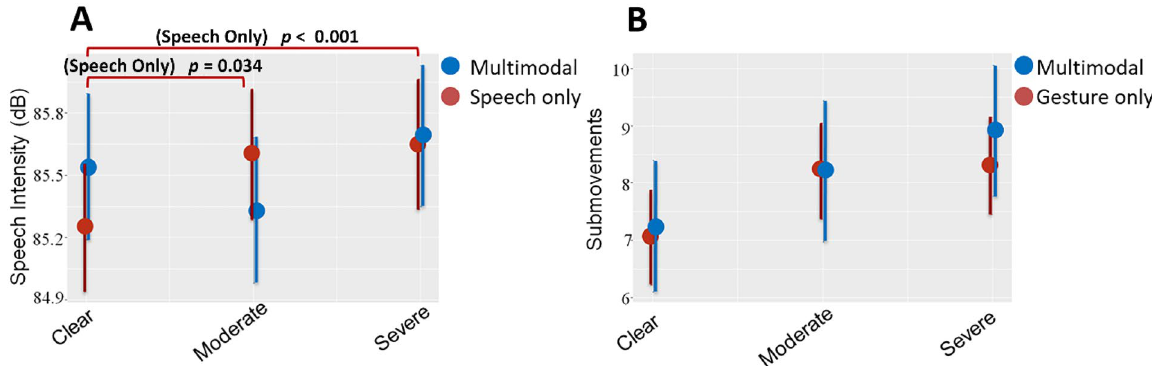
Figure 3. Speech intensity and gesture submovements across noise levels, as produced in unimodal or multimodal utterances. ( A ) Depicts speech intensity (y-axis), with blue lines representing multimodal (speech + gesture) utterances and red lines depicting unimodal (speech only) utterances. ( B ) Depicts submovements (y-axis), with blue lines representing multimodal (speech + gesture) utterances and red lines depicting unimodal (gesture only) utterances. In both plots, the three noise conditions are plotted on the x-axis. Circles represent the mean of the distribution, while line lengths extend to ± one standard deviation. p-values are provided for significant comparisons. Unmarked comparisons are